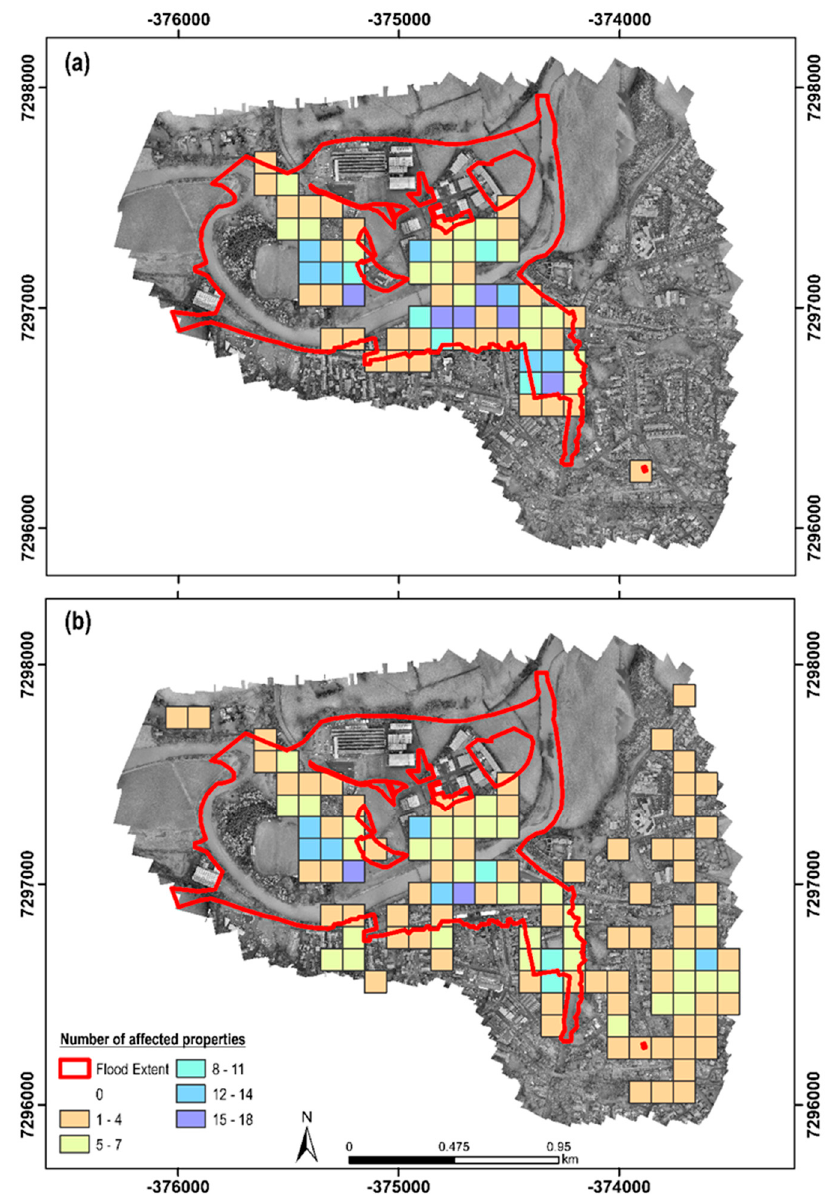
Figure 3. Number of residential properties in Cockermouth affected by flooding after Desmond (5–6 December 2015) based on ( a ) the classic loss adjustment approach that relies on the Environment Agency fluvial flood extent and ( b ) the UAV loss adjustment approach.